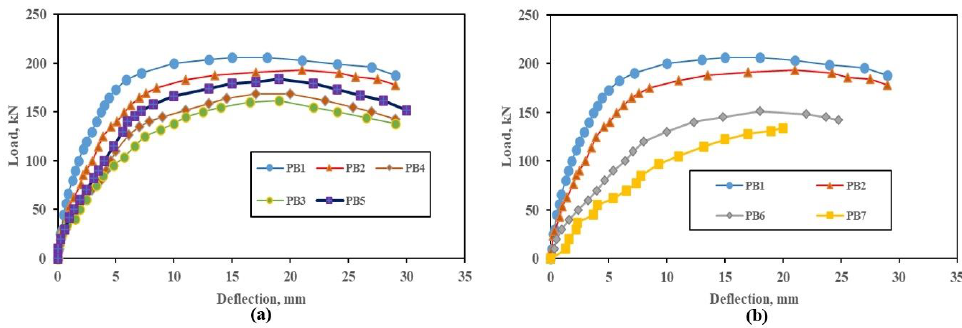
Figure 10: Load-deflection relationships: (a) reference beams and mechanical connecting beams; (b) reference beams and chemical con- necting